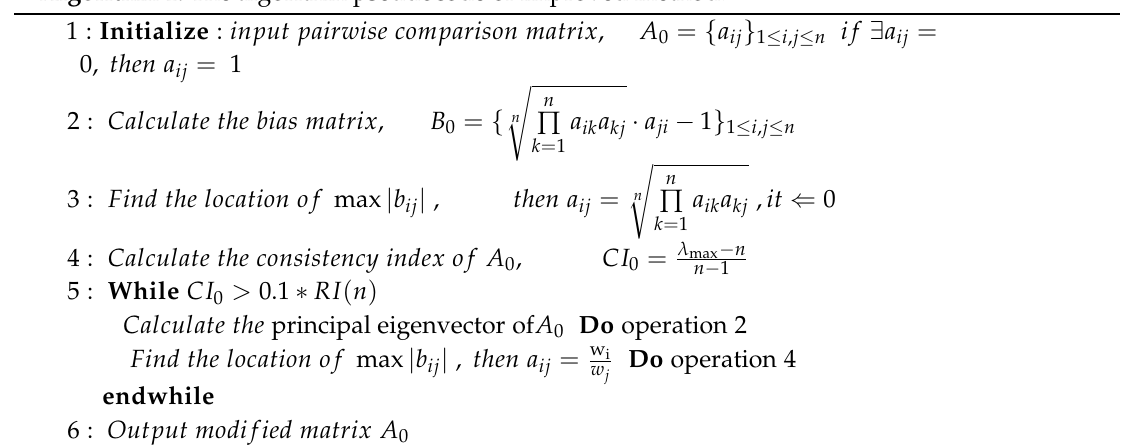
Algorithm 1: The algorithm pseudocode of improved